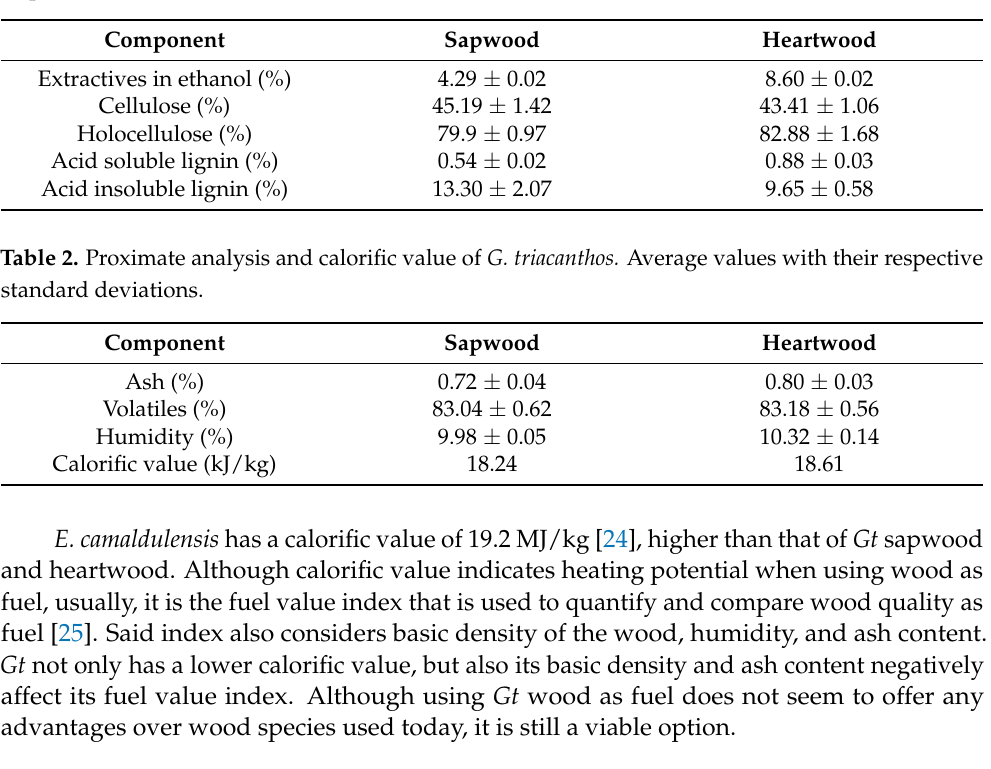
Table 1. Chemical composition of G. triacanthos sapwood and heartwood. Average values with their respective standard deviations.